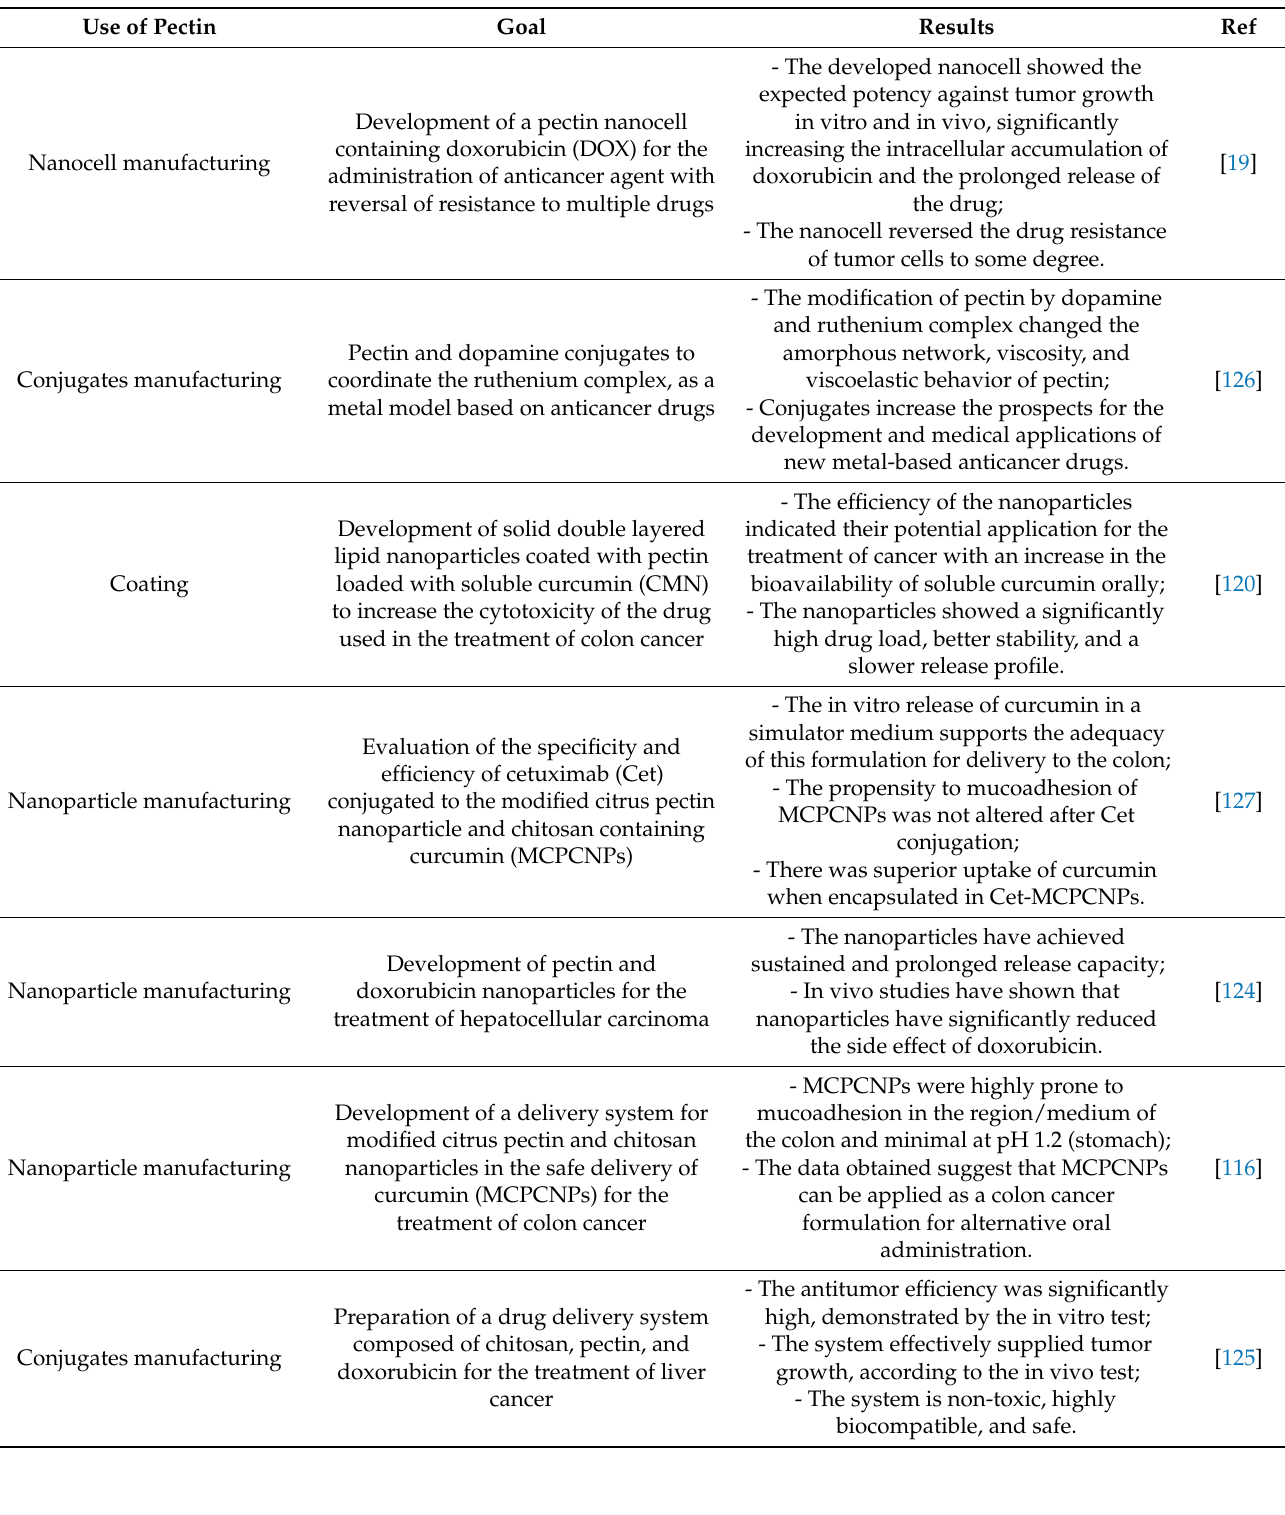
Table 5. Studies using pectin to treat